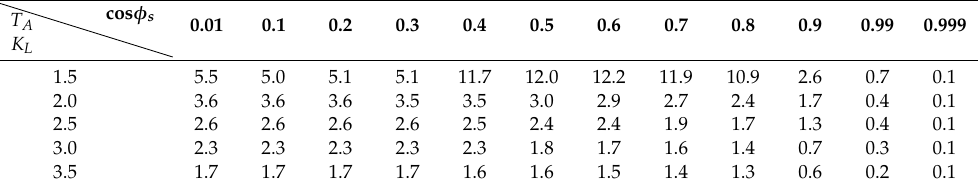
Table 5. Sample time with the criterion by di s / dt , ms.